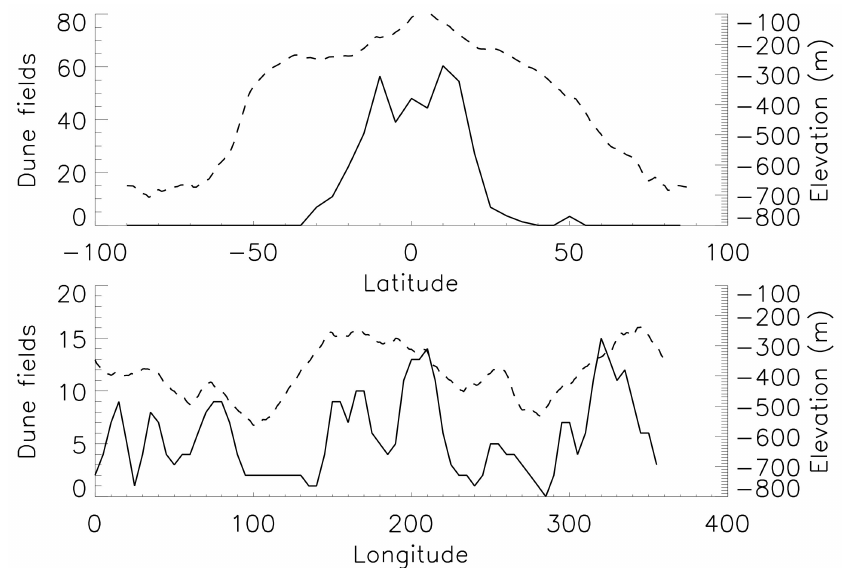
Figure 4. Profiles of the area-weighted number of 5 ◦ bins with dune fields (solid) and the area-weighted mean elevation in 1 ◦ bins (dashed) in latitude ( top ) and longitude ( bottom ).